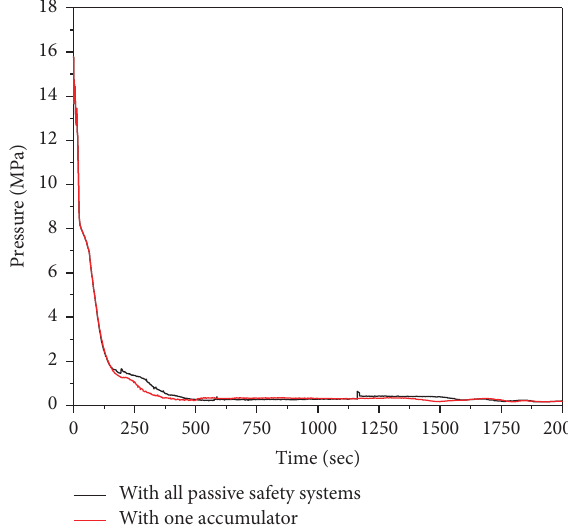
Figure 6: PRHR flow rate.